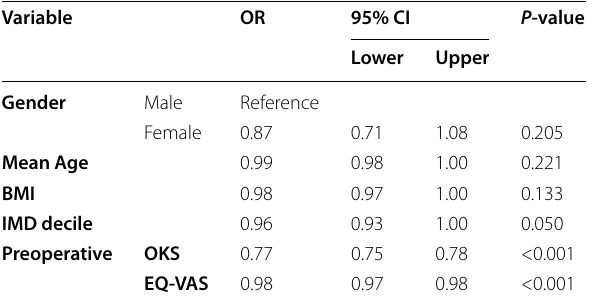
Table 2 Logistic regression analysis was used to assess the independence of preoperative variables associated with a health state WTD in patients awaiting a total knee arthroplasty. All preoperative variables from Table 1 were entered into the model (Nagelkerke R 2 0.46) =